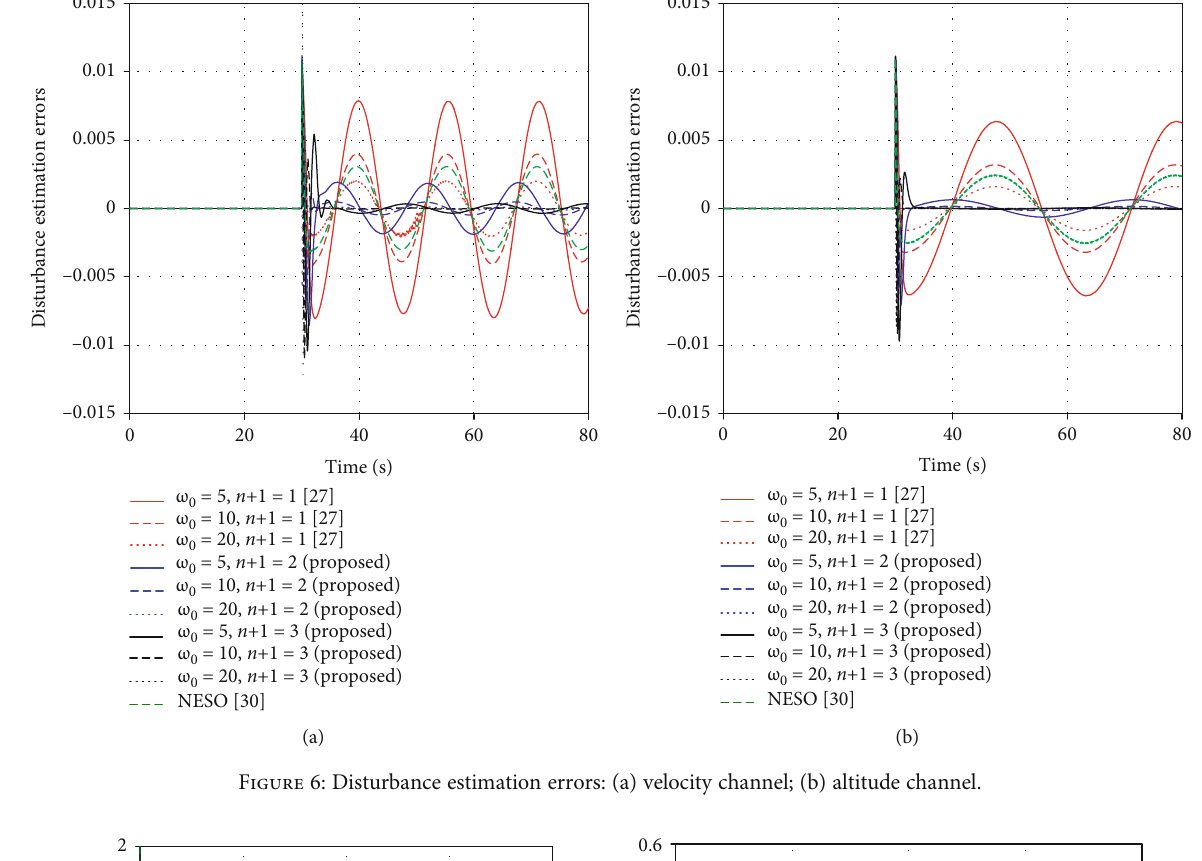
Figure 6: Disturbance estimation errors: (a) velocity channel; (b) altitude channel.